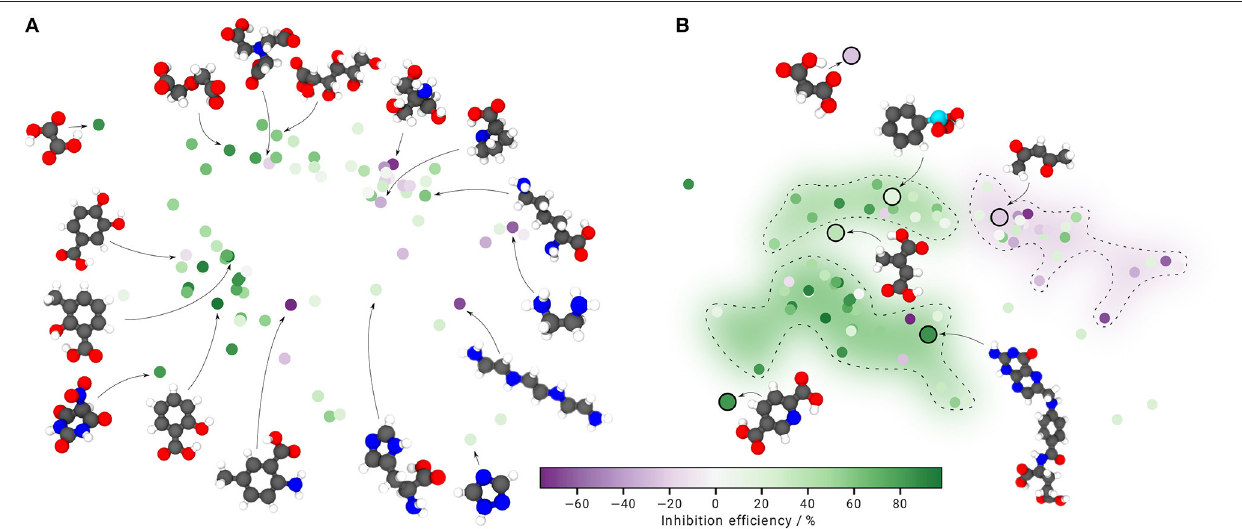
FIGURE 2 | Property-structure landscape based on the SOAP-REMatch kernel and sketch-map. (A) The structural data points are colored according to their corresponding inhibition efficiency in the experiment by Lamaka et al. (2017) (green ˆ= corrosion inhibition, purple ˆ= corrosion promotion). Selected molecular structures are shown to illustrate cluster origins. (B) Out-of-sample embedding to predict inhibition properties. New structures are projected into the generated sketch-map from (A) and related to previously identified inhibitor clusters, marked by dashed lines. The clusters are colored according to their median inhibition efficiency in the respective region. Landmarks are depicted as smaller circles; the new test structures as larger, black-rimmed circles along with illustrations of their according molecular structure . Atom color code: red ˆ= oxygen, gray ˆ= carbon, blue ˆ= nitrogen, whitish ˆ= hydrogen, cyan ˆ=